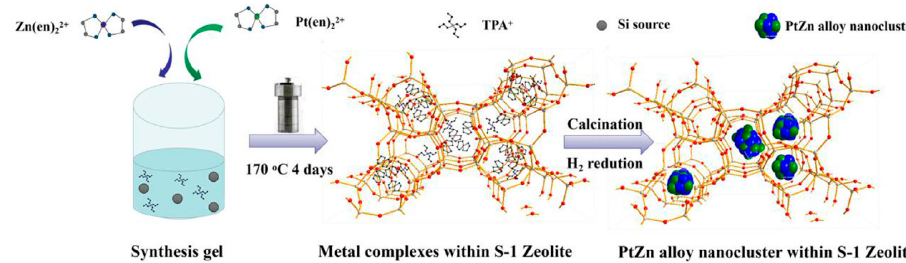
Figure 5. Illustration of the preparation of PtZn@S-1 catalyst. Reprinted with permission from ref. [72]. Copyright 2021 Elsevier .